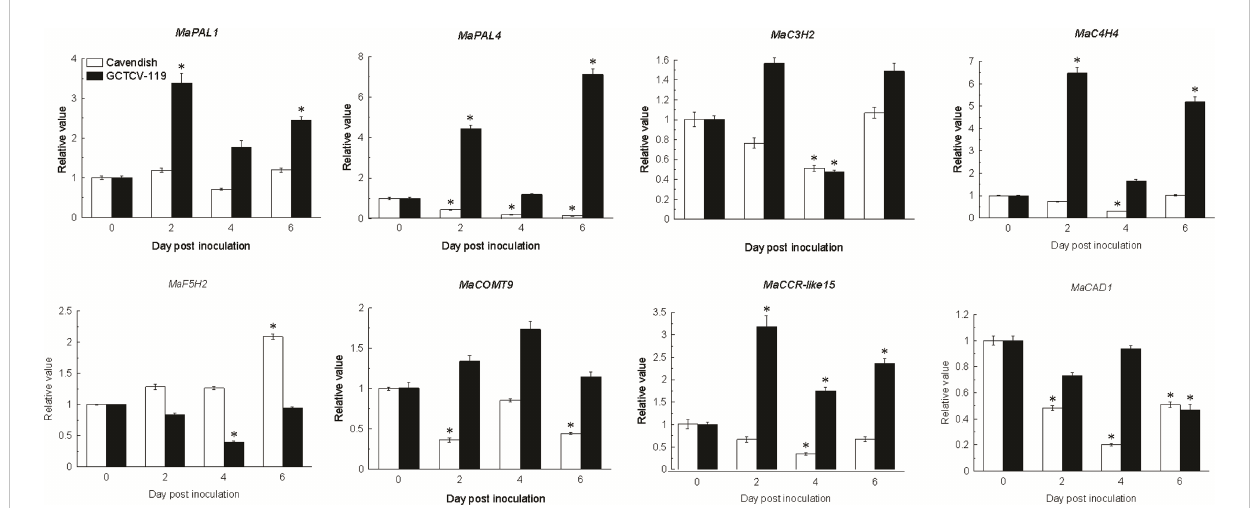
FIGURE 7 Expression patterns of lignin biosynthesis genes involving in plant-pathogen interaction pathway in Ba Xijiao and GCTCV-119 inoculated with Foc TR4 by qRT-PCR. The results are presented as differential relative transcript abundance. The data represent the mean ± standard deviation (SD) of three replicates. The y-axis shows the transcript fold-change relative to that in the control (0 DPI). * Signi fi cantly different from the control (0 DPI) at P < 0.01,